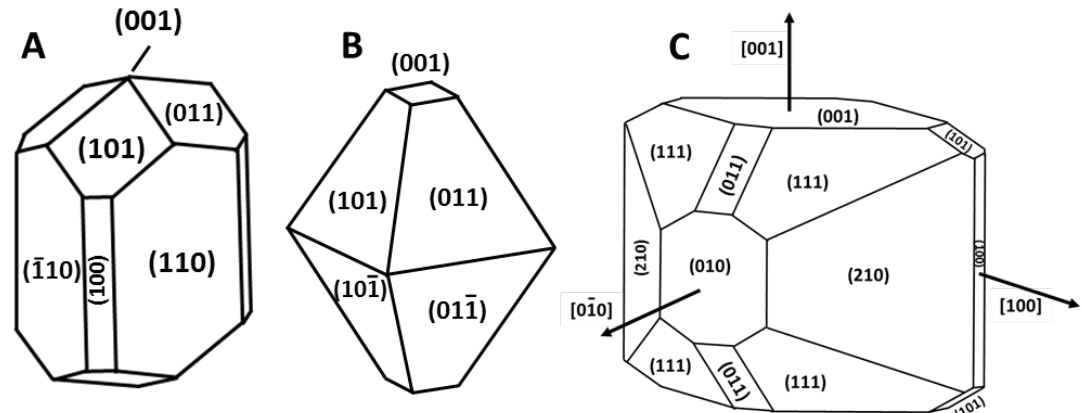
Figure 5. Equilibrium shape using Wulff construction for macroscopic crystals of rutile ( A ), anatase ( B ) and brookite ( C ). ( A and B ): adapted with permission from [60]. Copyright Elsevier, 2003. ( C ): adapted with permission from [78]. Copyright American Physical Society, 2007.